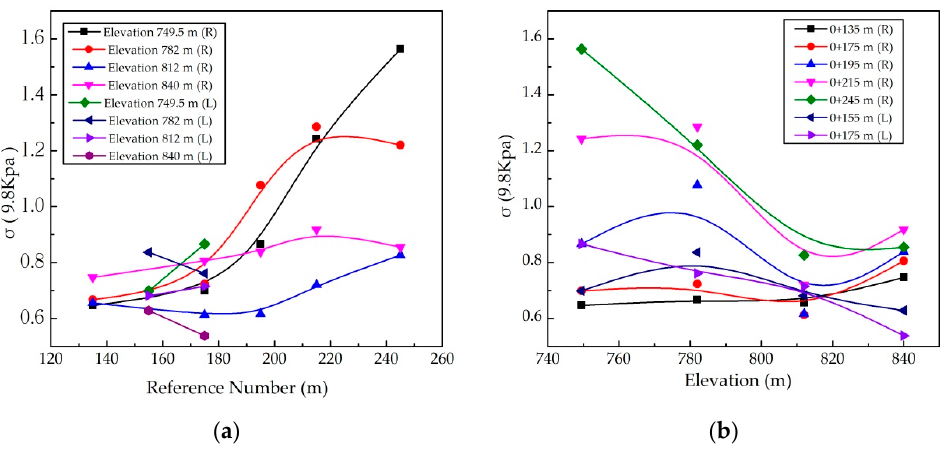
Figure 8. The RMS values σ of fluctuating pressure histories on slope protection plates under operating Condition 1. ( a ) along reference numbers; and ( b ) along elevation.